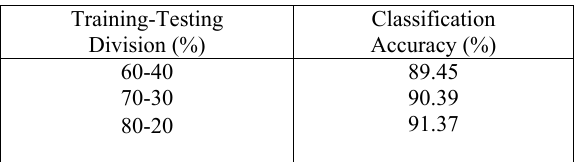
Table 2. Classification Accuracy with Different Training- Testing